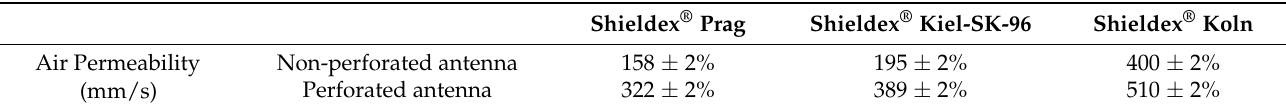
Table 4. The air permeability of non-perforated and perforated RRMPAs. Shieldex ® Prag Shieldex ® Kiel-SK-96 Non-perforated Air Permeability (mm/s)